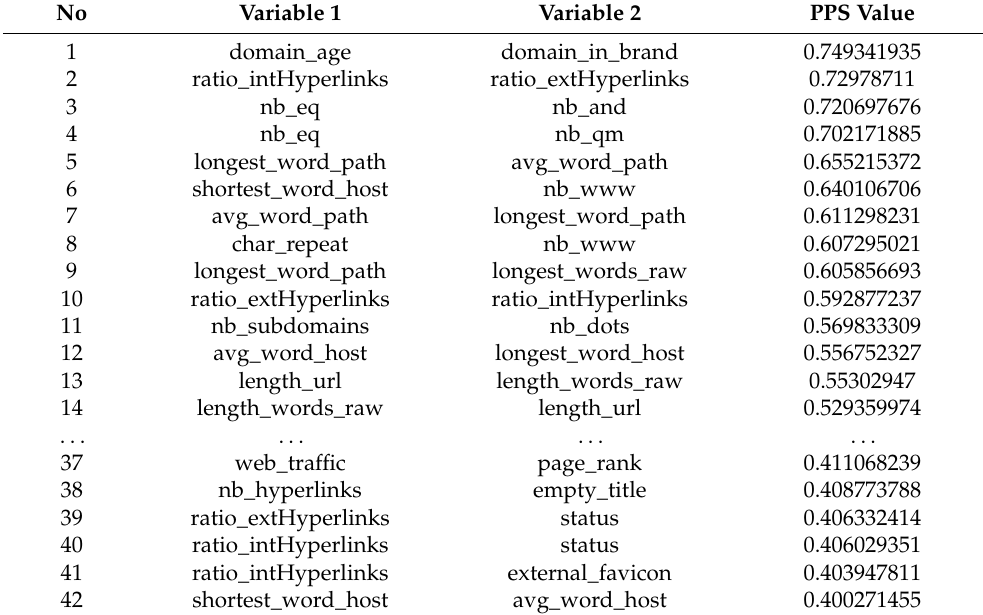
Table 4. PPS value between variables on Dataset